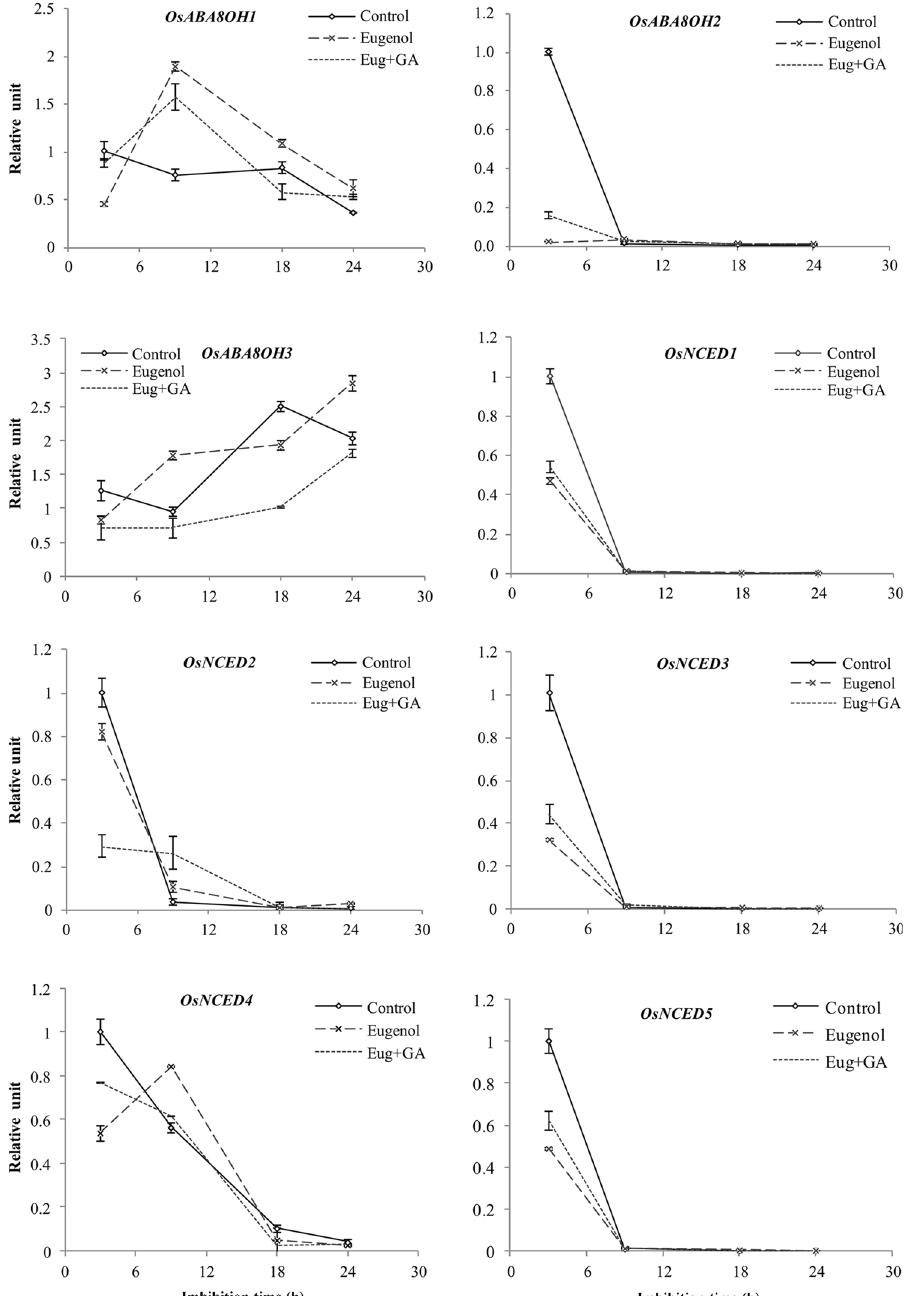
Figure 6. Changes of gene expression profiles of ABA metabolism during seed germination in Qian You 1. Gene expression profiles of ABA metabolism genes ( OsNCED1 , OsNCED2 , OsNCED3 , OsNCED4 , OsNCED5 , OsABA8OH1 , OsABA8OH2 , OsABA8OH3 ) were measured from 3 h to 24 h in rice cultivar Qian You 1. Control: seeds soaked in water; Eugenol: seeds soaked in 2.0 g · L − 1 of eugenol; Eug + GA: seeds soaked in 2.0 g · L − 1 of eugenol + 50 mg · L − 1 of GA 3 mixed solution. The data were the means of three replications, and the standard deviation was indicated by